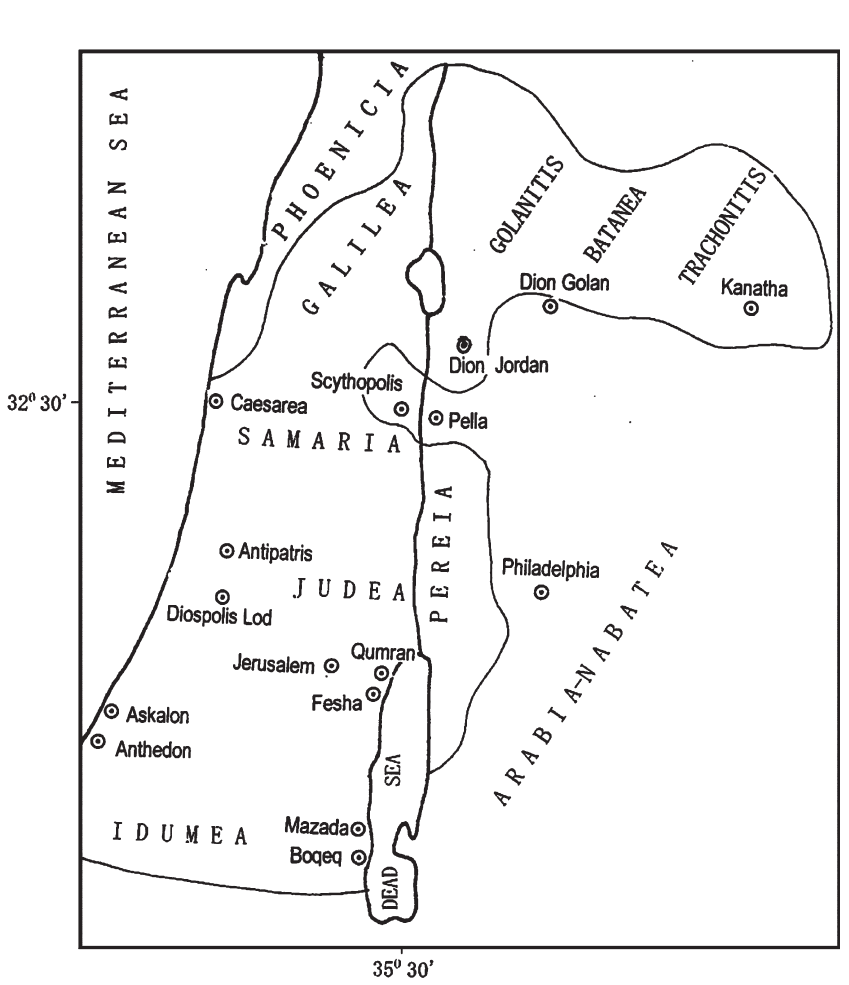
Fig. 5. Orientation map for the 31 B.C.